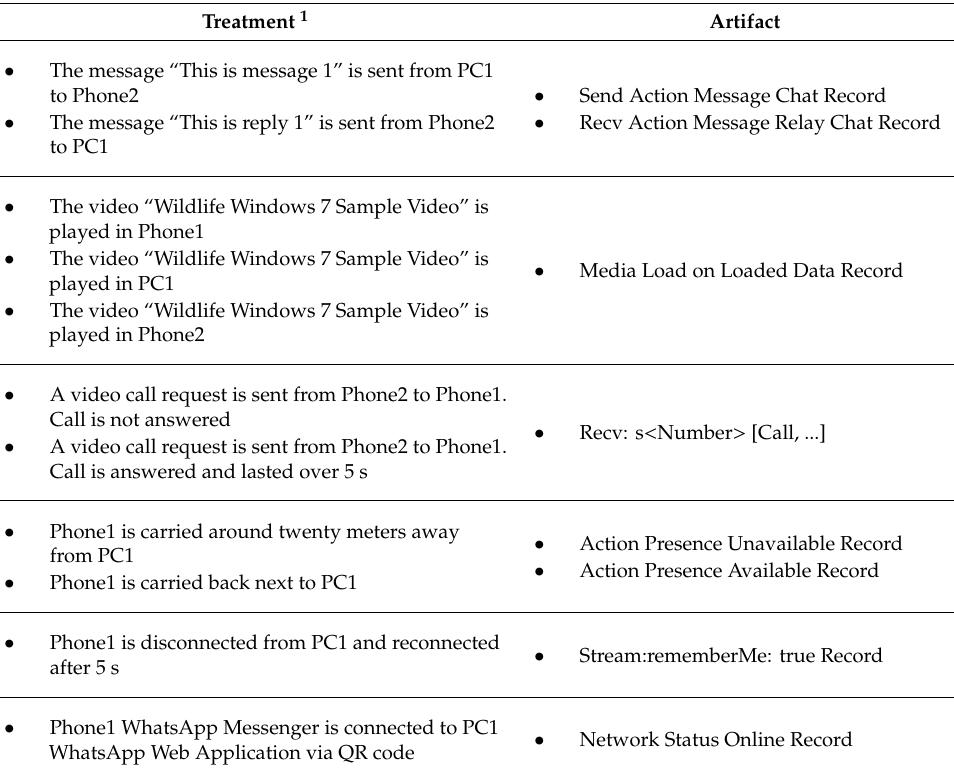
Figure 1. A .log file taken from Google Chrome IndexedDB file storage location. Table 1. Treatments and Artifacts